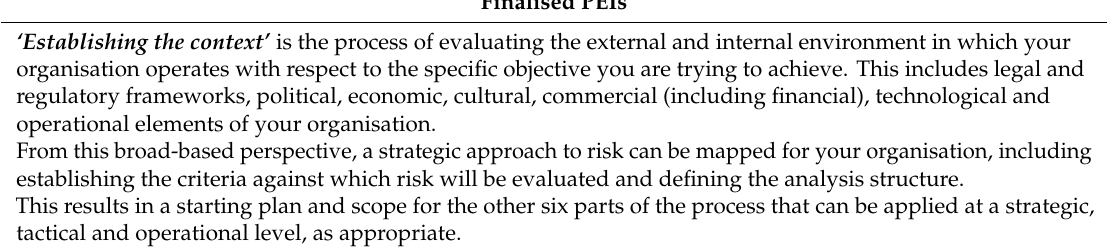
Table 4. Finalised PEIs. Finalised